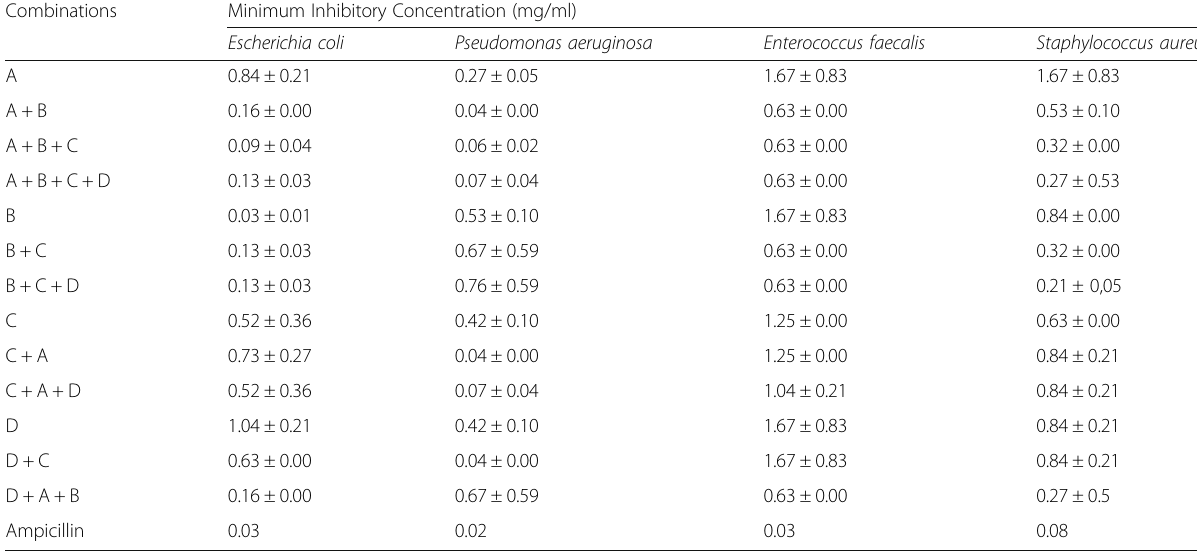
Table 1 Antibacterial interaction effects with standard deviation of the acetone extracts of the different combinations of the selected plants against selected bacterial species Combinations